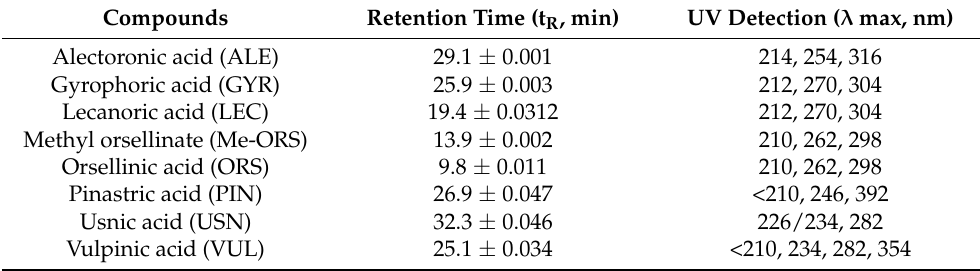
Table 1. Retention times and UV absorbance maxima (nm) of main secondary metabolites of stud- ied